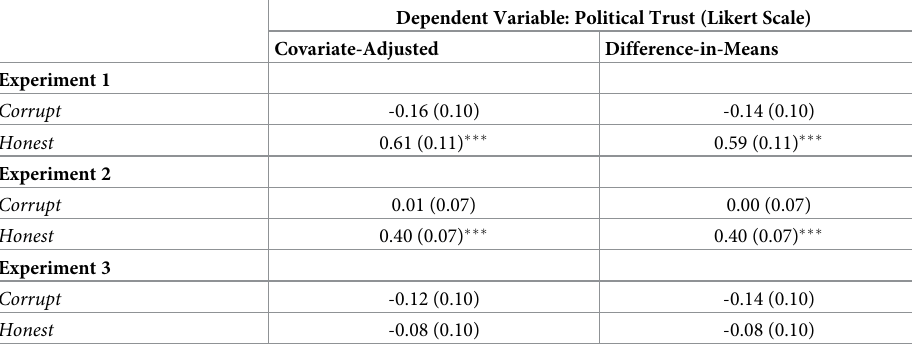
Table 2. Estimated treatment effects and standard errors in Experiments 1–3.